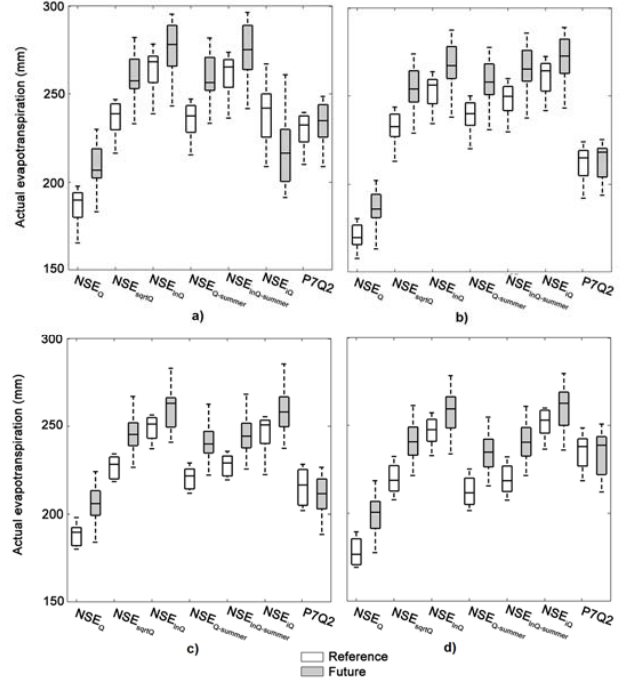
Figure 10. Sum of actual evapotranspiration simulated with the GR4J model for the summer (May to October) for the ( a ) Cowansville; ( b ) Farnham; ( c ) Noire River; and ( d ) St-Hyacinthe sub-watersheds.